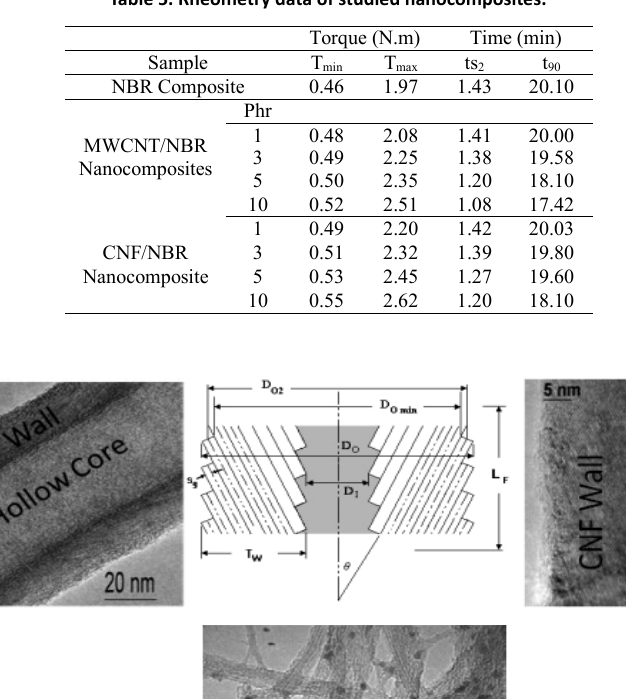
Table 5. Rheometry data of studied nanocomposites.